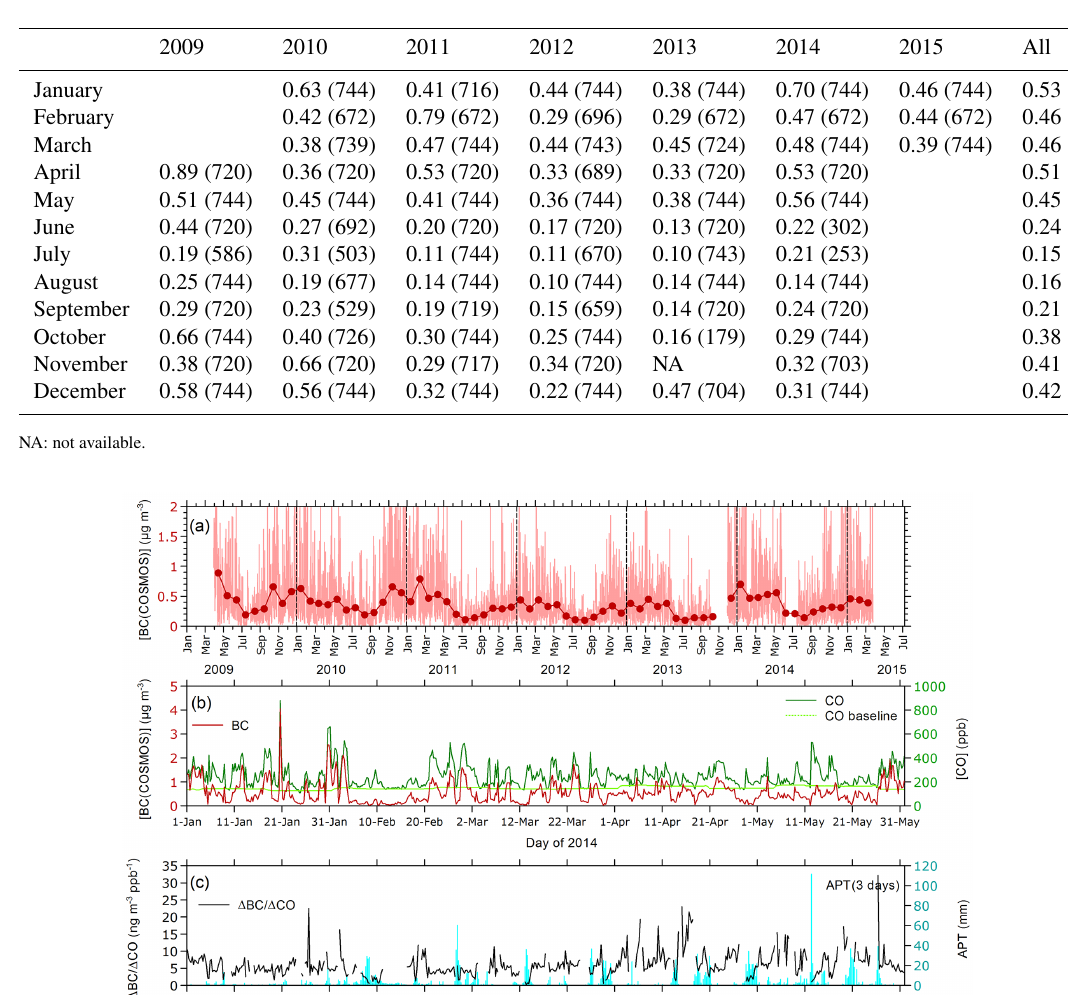
Table 1. Monthly average BC mass concentrations derived using COSMOS instrument at Fukue Island (unit: µgSTPm − 3 ) . Number of hourly measurements included in month is in parentheses.